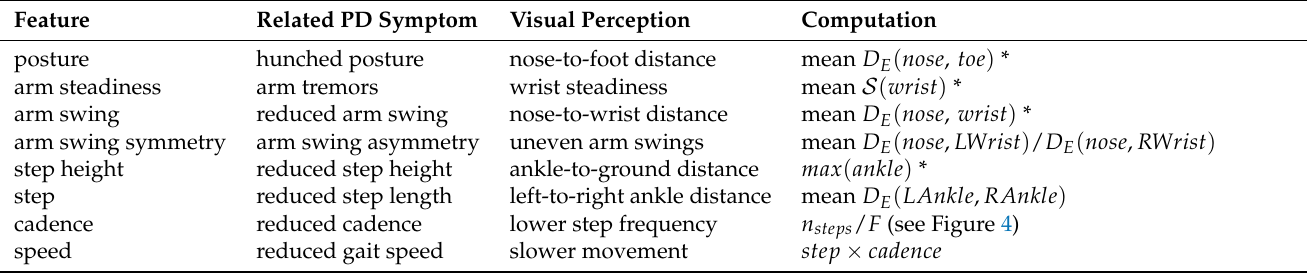
Figure 4. Estimating number of steps based on the peaks of step length. The peaks correspond to heel strikes, and counting them gives the number of steps n steps taken by the subject in the video. Table 1. Description of features extracted from